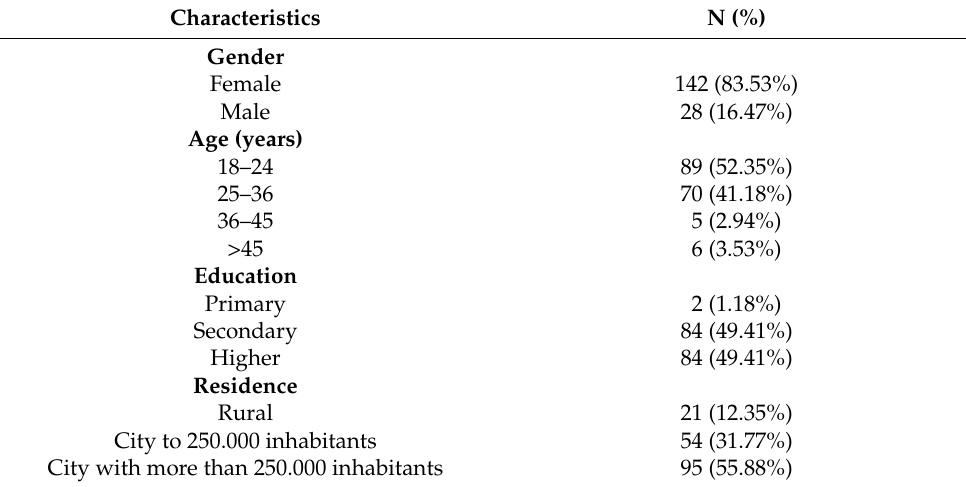
Table 1. Demographic characteristics of the study group.